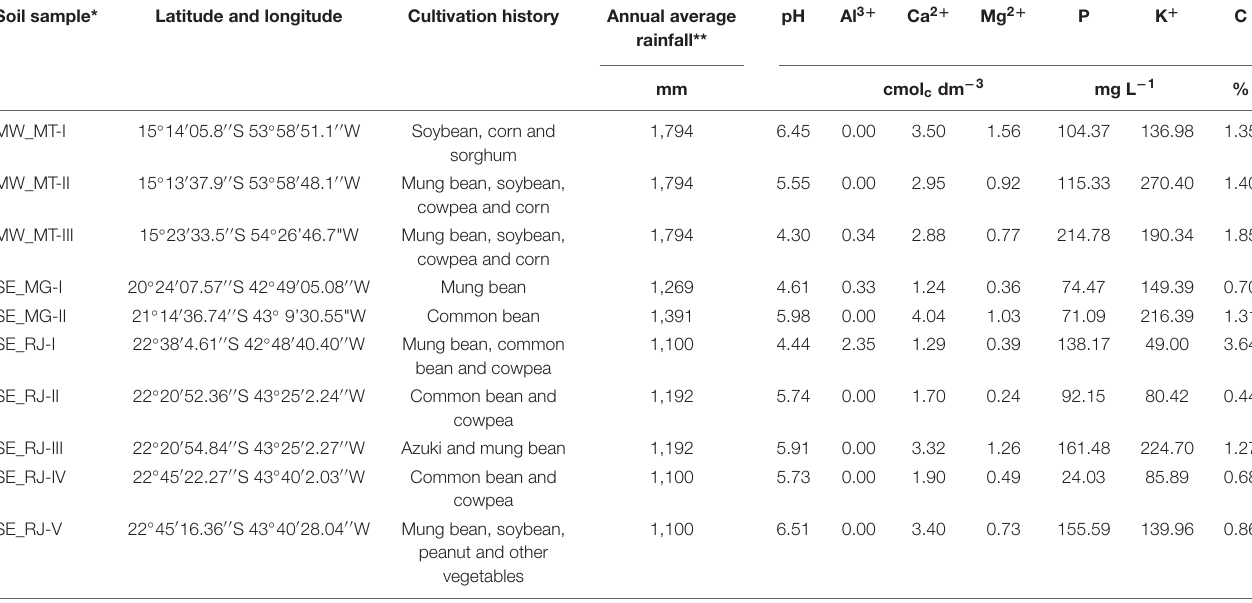
TABLE 1 | Soil sample identification, location, cultivation history, precipitation, and fertility analysis of soil material used for planting mung bean in Leonard jars. Soil sample* Latitude and longitude Cultivation history Annual average